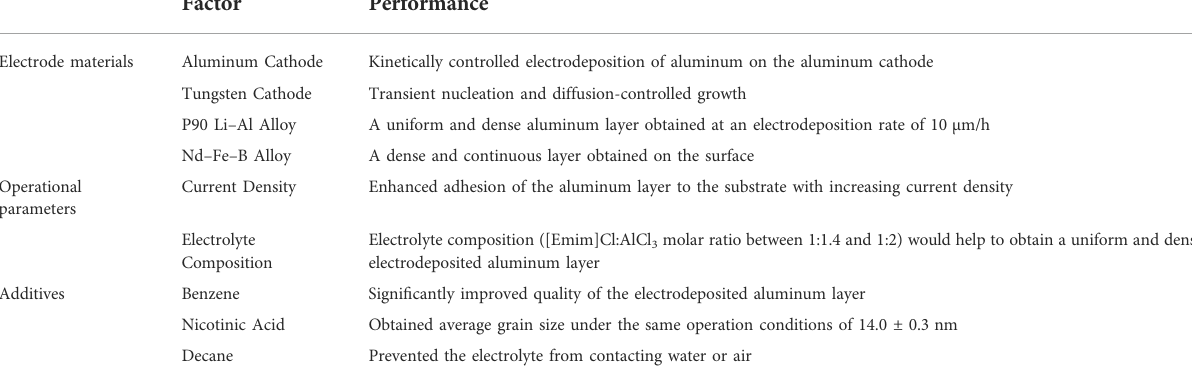
TABLE 2 Factors affecting the performance of ionic liquid-based electrolytic aluminum ([Emim]Cl/AlCl 3